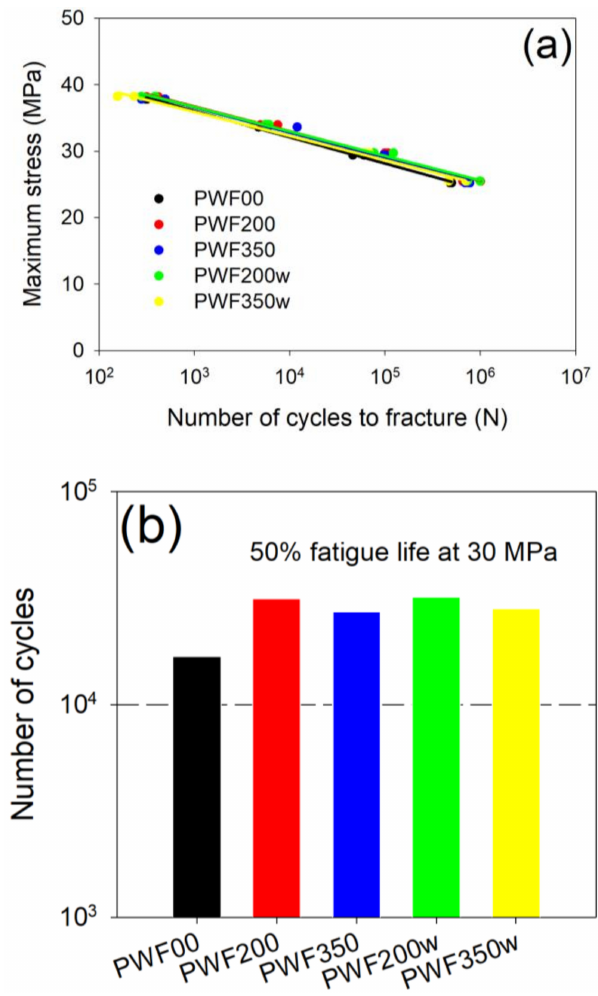
Figure 8. ( a ) S–N curves and ( b ) half-fatigue life of PWF type composites: PWF00, PWF200, PWF350, PWF200w, and